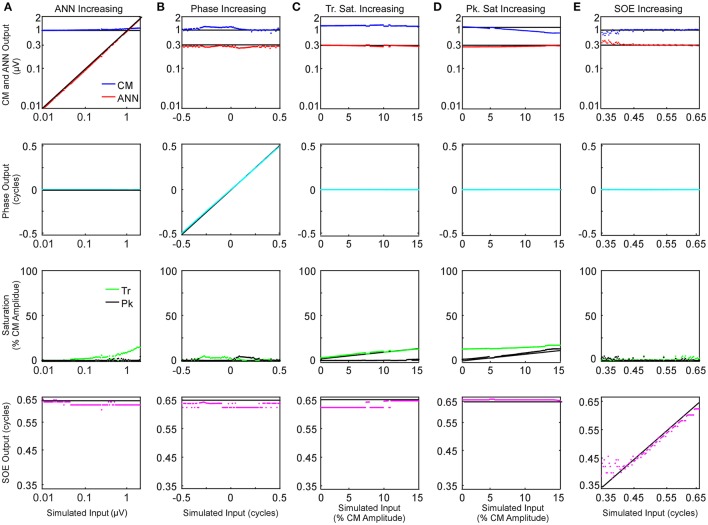
Parametric examination of model outputs to simulated signals. The parameter varied is changed along the columns (A–E), and the responses obtained for each parameter is varied by row. (A) The ANN amplitude was gradually increased from 0.01 to 2 μV with CM amplitude of 1 μV, no phase difference between the two signal components or trough or peak saturation, and SOE of 0.65 cycles. (B) The phase difference between the two CM and ANN was gradually increased from −0.5 to 0.5 cycle while CM amplitude was 1 μV, no trough or peak saturation, and ANN amplitude was 0.3 μV with SOE of 0.65 cycle. (C) The trough saturation of the CM component was varied from 0 to 15% of the CM amplitude with no peak saturation, the ANN amplitude was 0.3 μV in dB and SOE 0.65 cycles while the phase difference between the two signal components was zero. (D) The degree of peak saturation of CM was varied from zero to approximately 10% of the CM amplitude of 1 μV while trough saturation was stable at 15% of the CM amplitude; ANN amplitude was 0.43 μV in dB, SOE 0.65 cycles and phase difference between the two components zero. (E) The SOE increased from 0.35 to 0.65 cycles while the CM amplitude was 1 μV, ANN amplitude was 0.3 μV and no trough or peak saturation and the phase difference between these two signal components was zero.